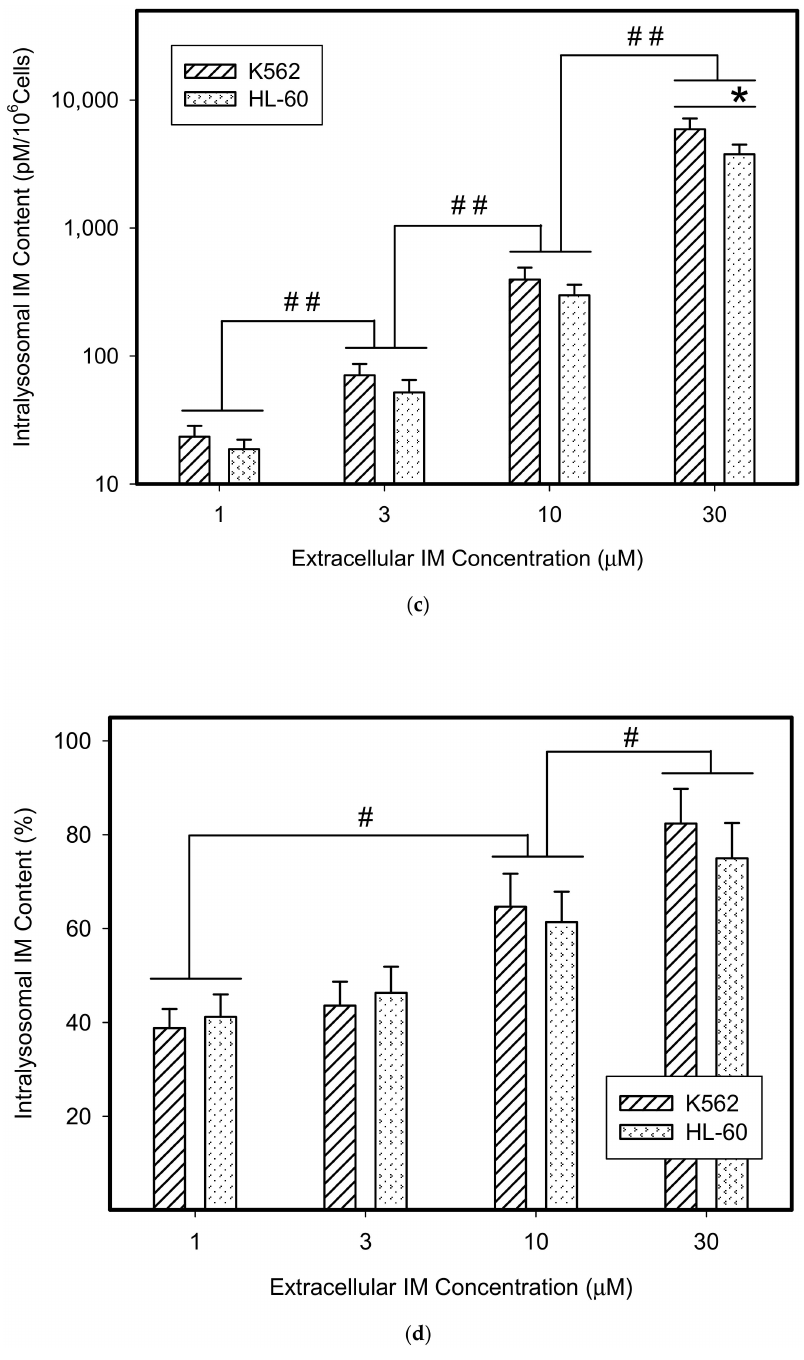
Figure 1. Lysosomal sequestration of tyrosine kinase inhibitors (TKIs). Absolute accumulation of TKI in lysosomes is expressed as molar amount of particular TKI in lysosomes per 10 6 cells. Relative accumulation of TKIs is calculated as the ratio: (intralysosomal accumulation of particular TKI / intracellular accumulation of particular TKI) × 100%. ( a ) Absolute accumulation of gefitinib (GF) in lysosomes of cancer cells. ( b ) Relative accumulation of GF in lysosomes of cancer cells. ( c ) Absolute accumulation of imatinib (IM) in lysosomes of cancer cells. ( d ) Relative accumulation of IM in lysosomes of cancer cells. The columns represent the means of four independent experiments with standard deviations. * denotes significant change in the intralysosomal GF or IM content ( p < 0.05) between the K562 and HL-60 cells. # denotes significant change in the intralysosomal content of GF or IM ( p < 0.05) between the indicated groups. ## denotes a very significant change in the intralysosomal content of GF or IM ( p < 0.01) between the indicated